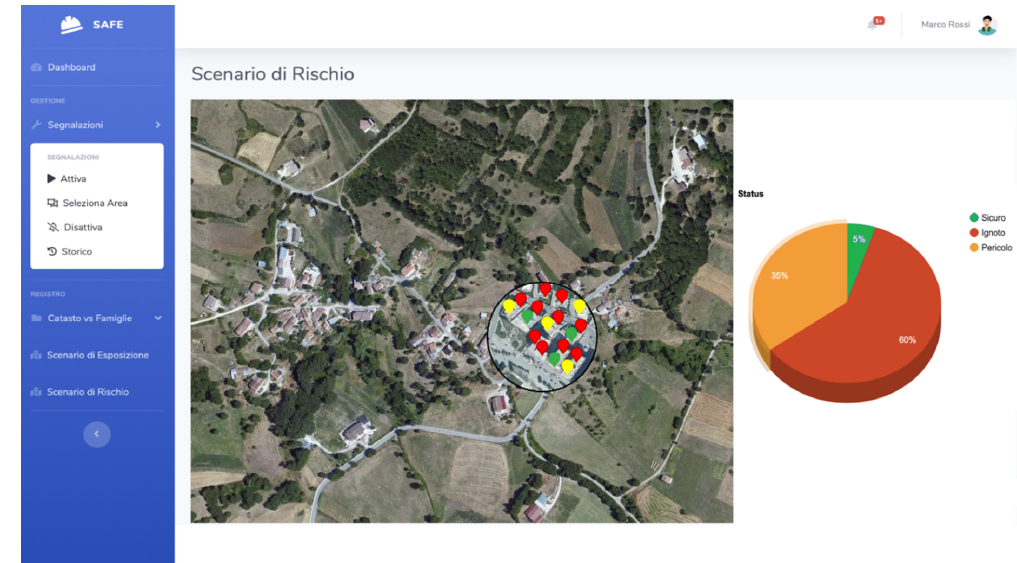
Figure 22. The exposure scenario after citizens’ feedbacks.